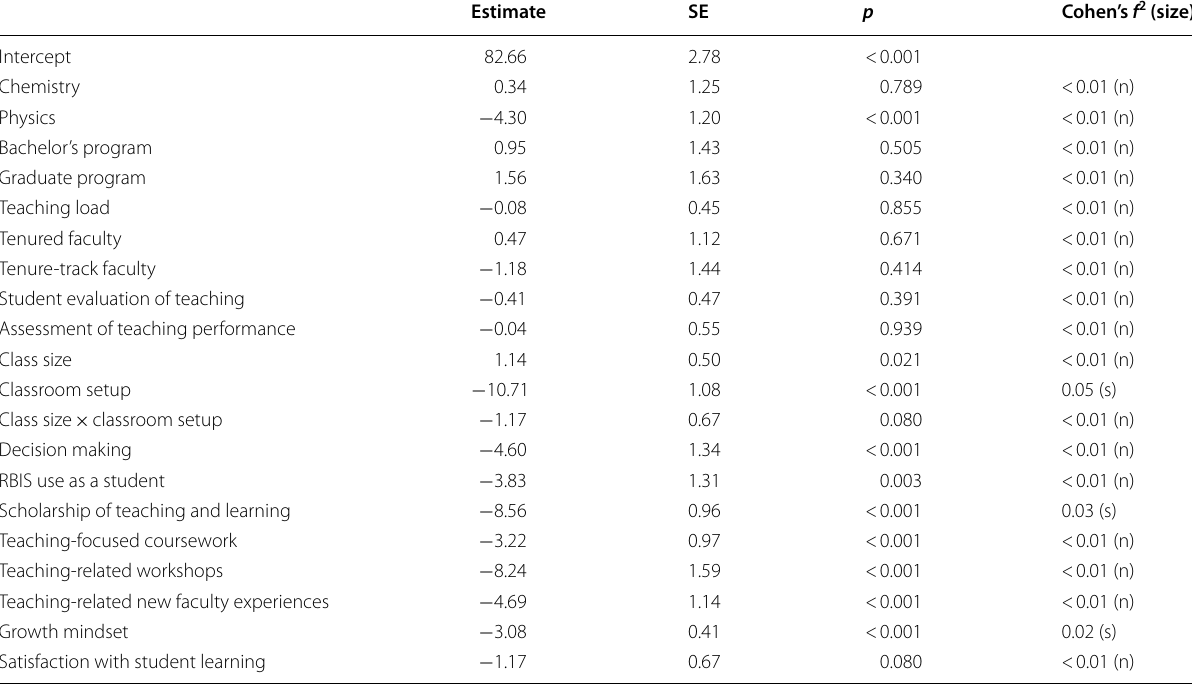
Table 2 Factors in explaining percent lecturing in introductory chemistry, mathematics, and physics